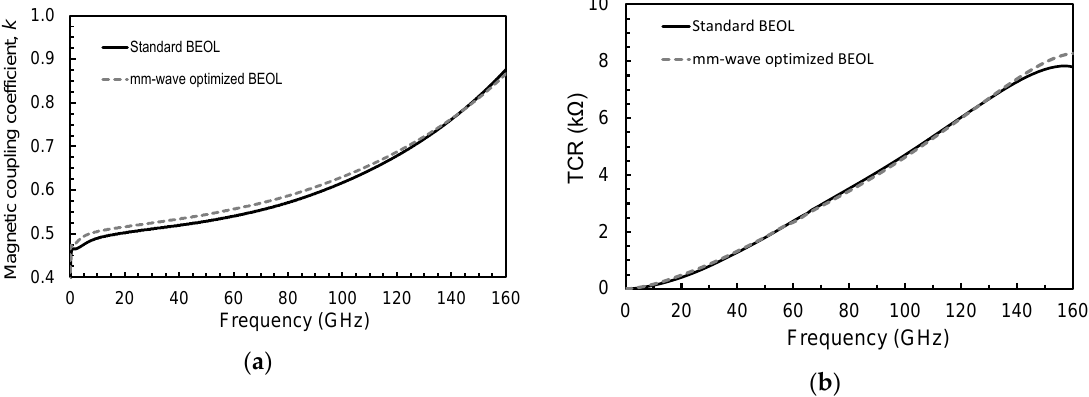
Figure 10. BEOL comparison for interleaved transformer T 2 of Table 2: ( a ) magnetic coupling coefficient k; ( b ) transformer characteristic resistance, TCR .